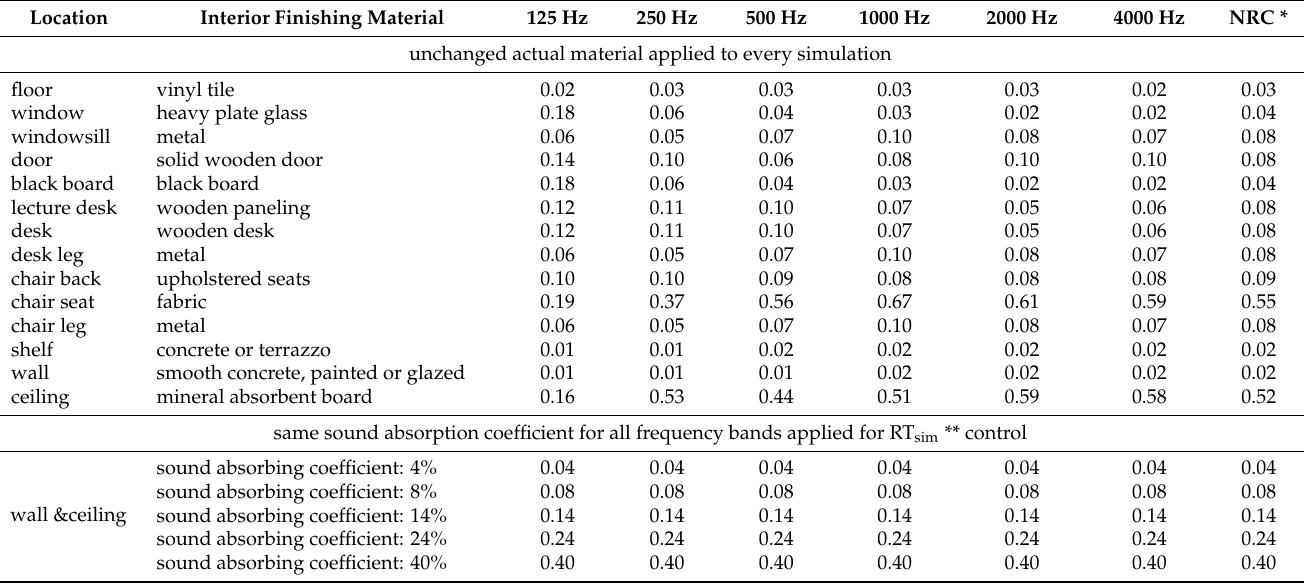
Table 5. Noise reduction coefficient (NRC) for computer simulation in